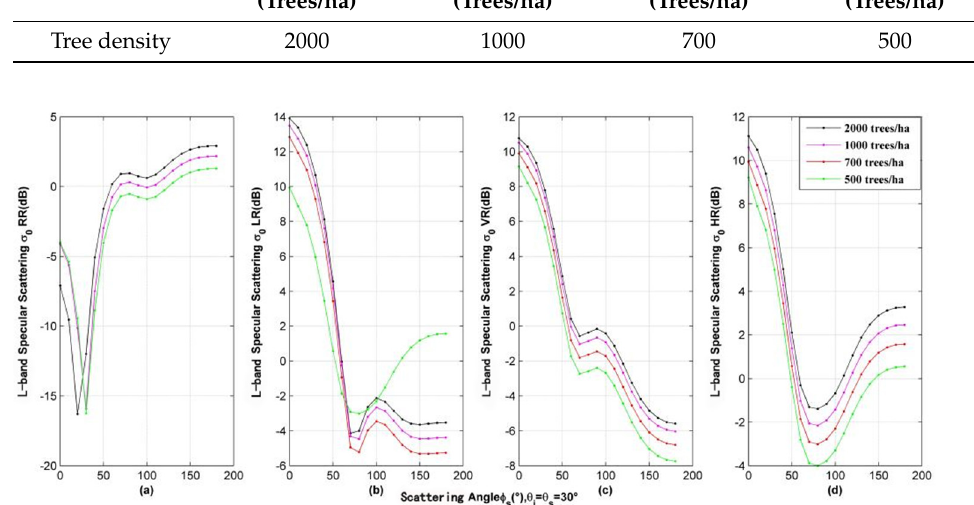
Table 5. Tree density for four different forest scenarios.